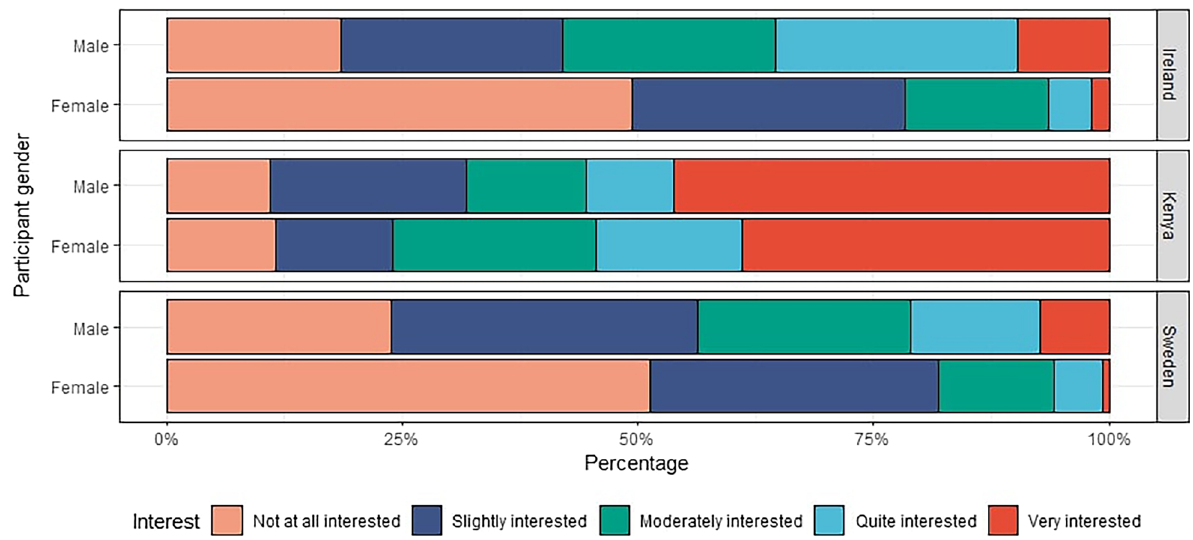
Fig. 4 Responses to the Likert item “how interested are you in being an engineer?” By students’ gender and country